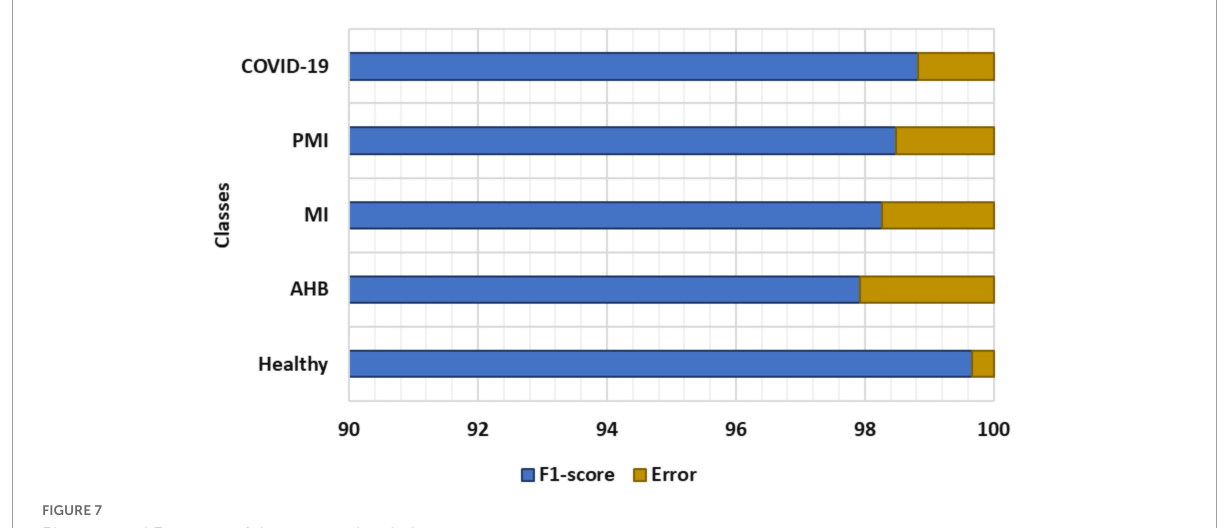
FIGURE7 F1_score and Error rate of the proposed